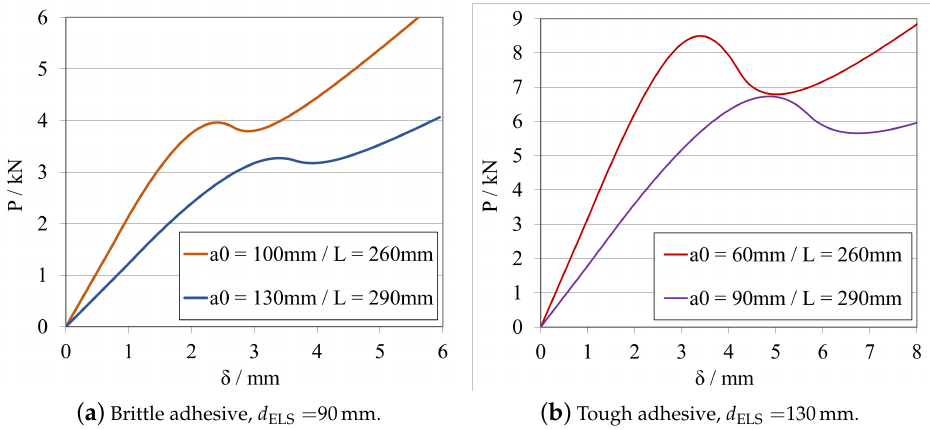
Figure 14. P - δ curves related to different combinations of a 0 ELS and L ELS , to attain the same d ELS